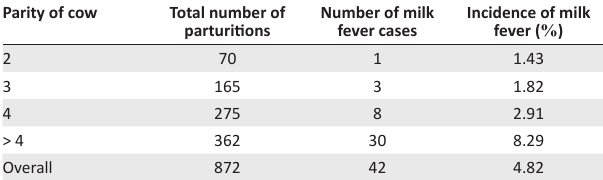
TABLE 3: Incidence of milk fever according to parity in Holstein cows. Parity of cow